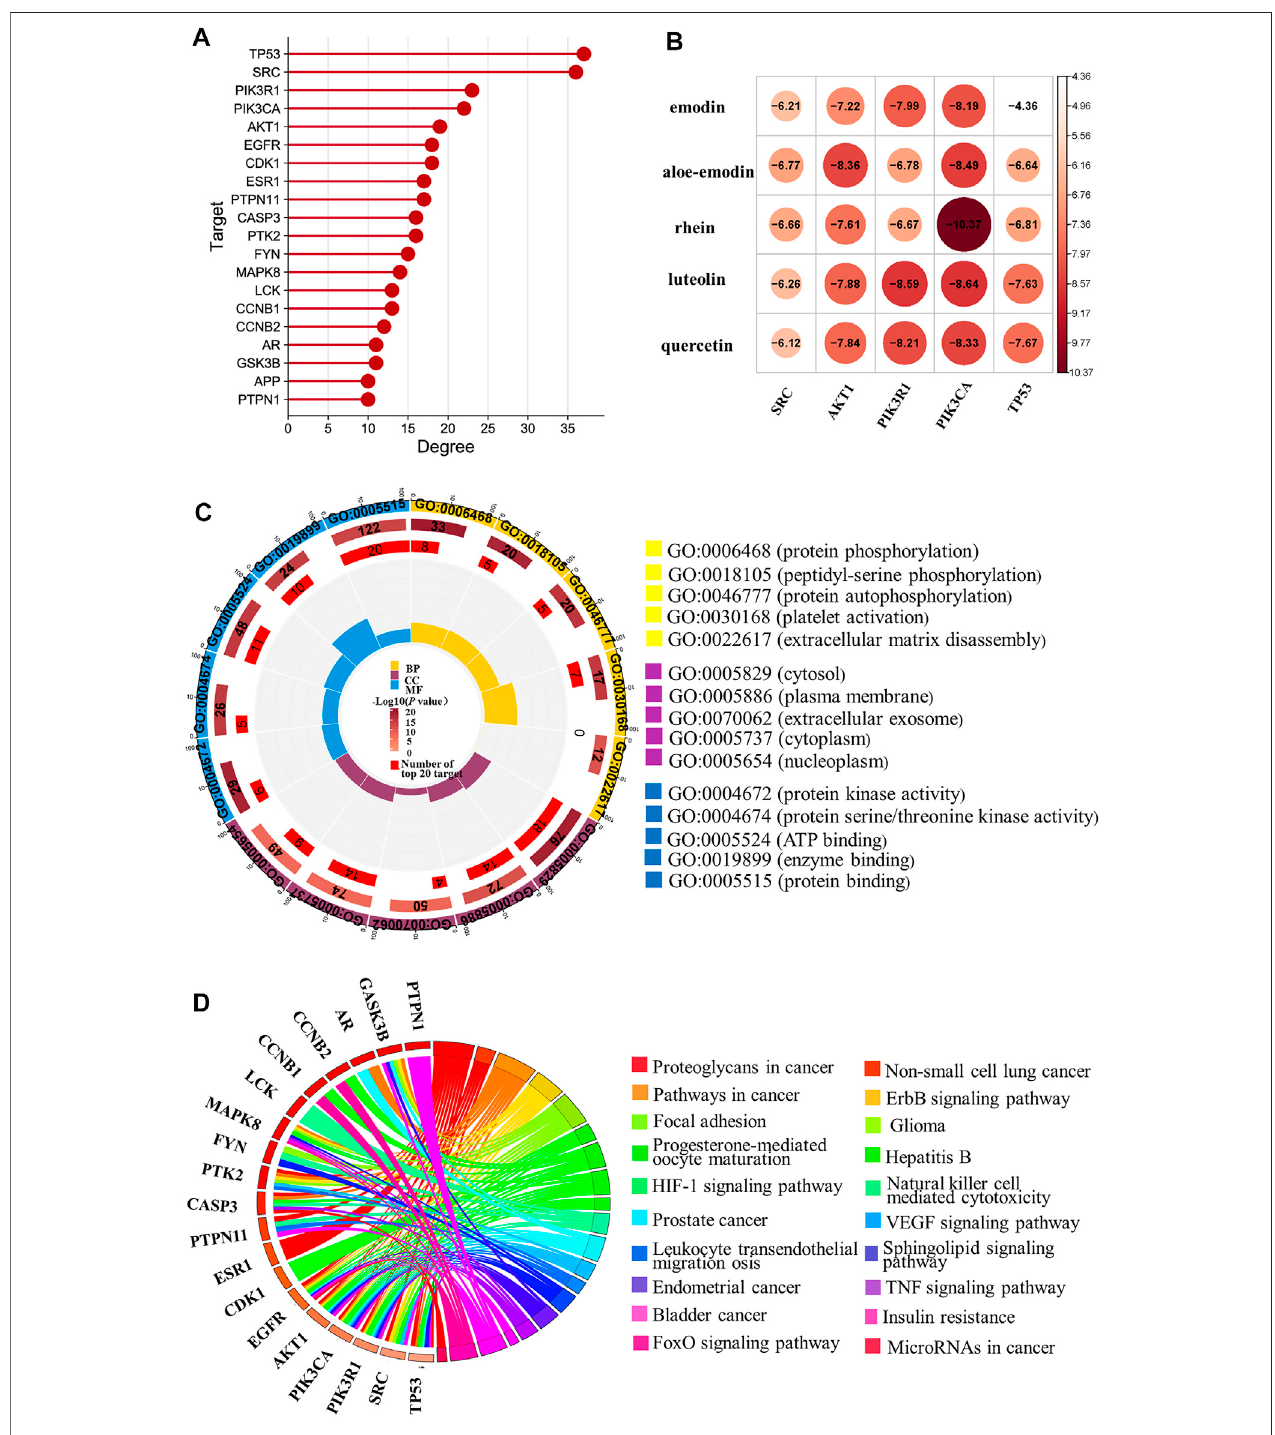
FIGURE2| Networkpharmacologyanalysisofkeycompoundsinplasma. (A) Top20targetsofPPI; (B) moleculardockingresultsofthekeycompoundsinplasma with top fi ve targets of PPI; (C) GO enrichment of the key compounds in plasma; (D) pathway-target diagram of key compounds in plasma.